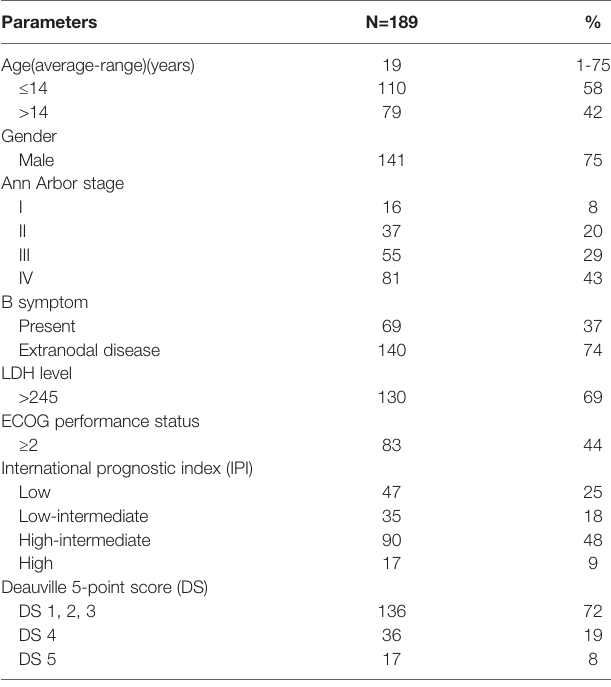
TABLE 1 | Patient